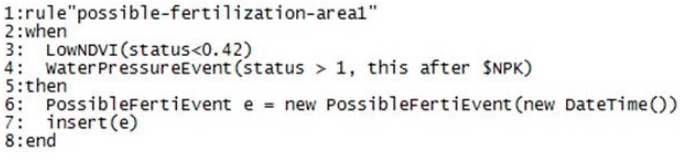
Figure 14. Event triggered.